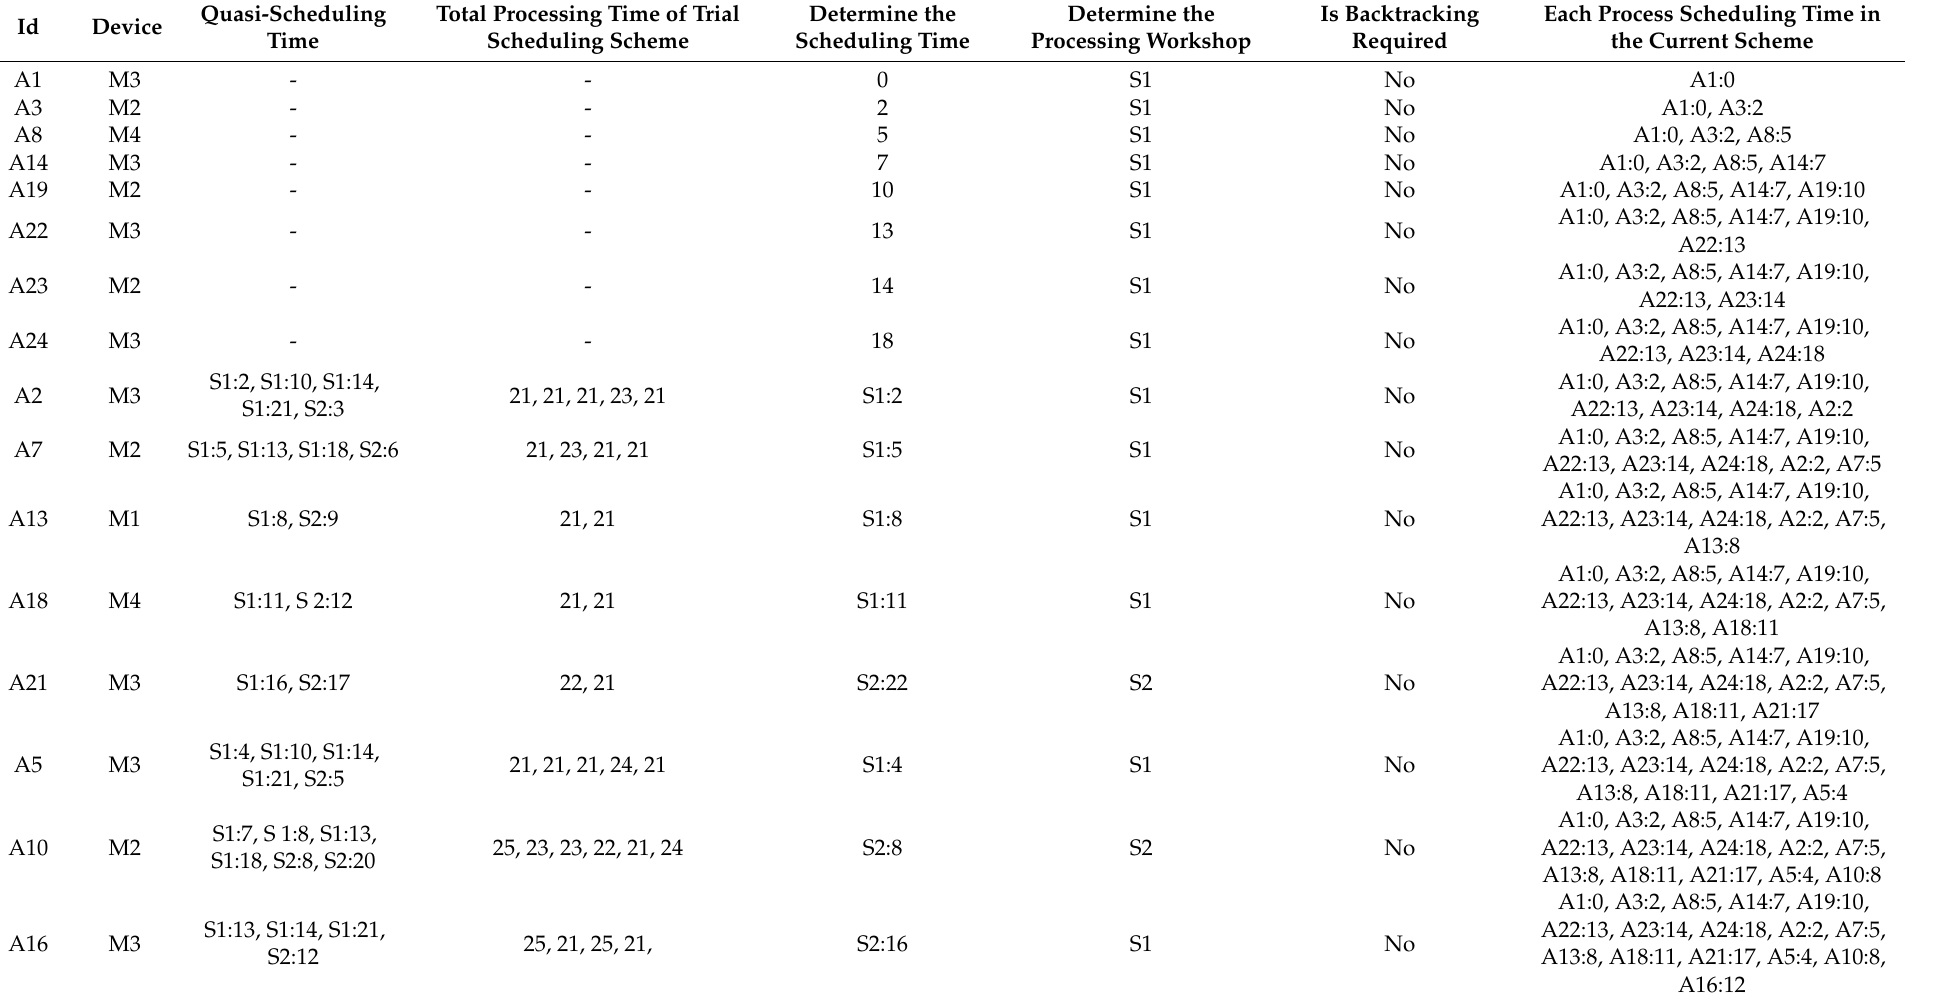
Table 1. The scheduling process data of product A scheduled by the proposed